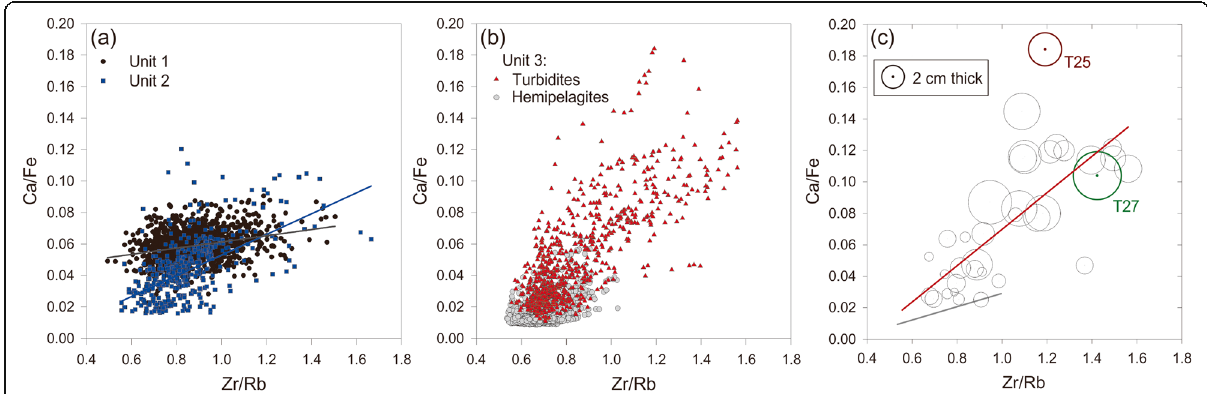
Fig. 9 Plots of Ca/Fe vs. Zr/Rb for a sedimentary units 1 (black circles) and 2 (blue squares), b hemipelagites (gray circles) and turbidites of sedimentary unit 3 (red triangles), and c 36 individual turbidites (maximum values). Regressions for sedimentary units 1 and 2 are shown as black and blue lines, respectively, in a . Symbol sizes in c represent the thickness of each turbidite bed. Turbidite T25 (red circle, 2.9 cm thick) has the highest Ca/Fe value of all analyzed turbidite beds. Turbidite T27 (green circle) is the thickest observed turbidite bed (4.2 cm). Regressions for turbidites and hemipelagites are shown as red and gray lines, respectively, in c